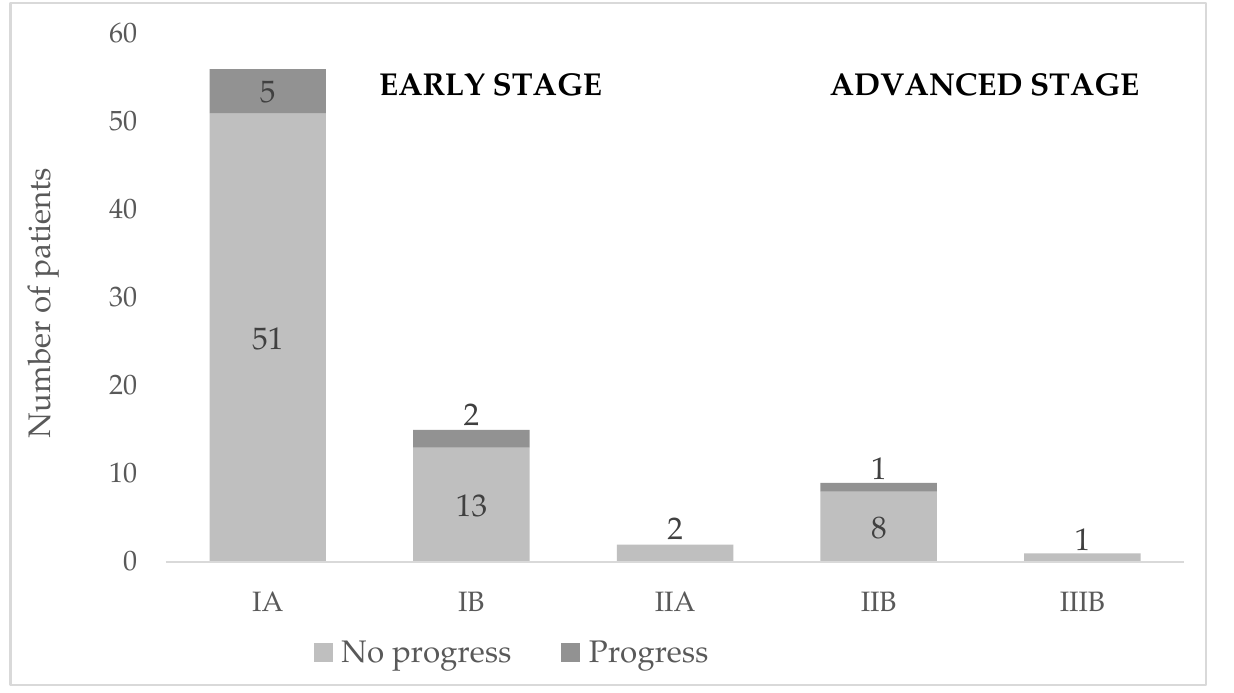
Figure 3. Staging at initial diagnosis of mycosis fungoides and progression (dark grey top of the bars) to more advanced stages (where stages IIB and IIIB are considered advanced-stage disease) during the study period.